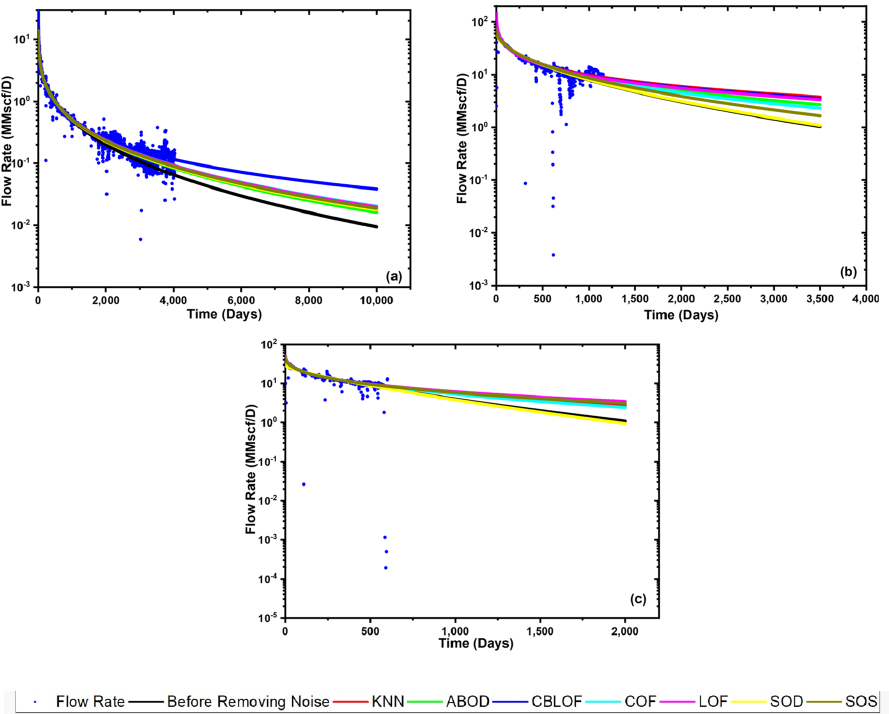
Figure 21. Applying the SEPD and PLE decline models before and after removing noise using the seven OD algorithms for; ( a )Well_12, ( b ) Well_29, and ( c ) Well_40.